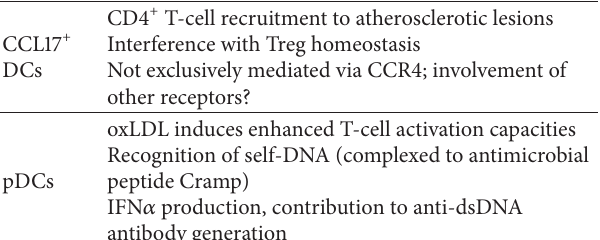
Table 1: Atherogenic CCL17 + DC and pDC functions in a nutshell. CCL17